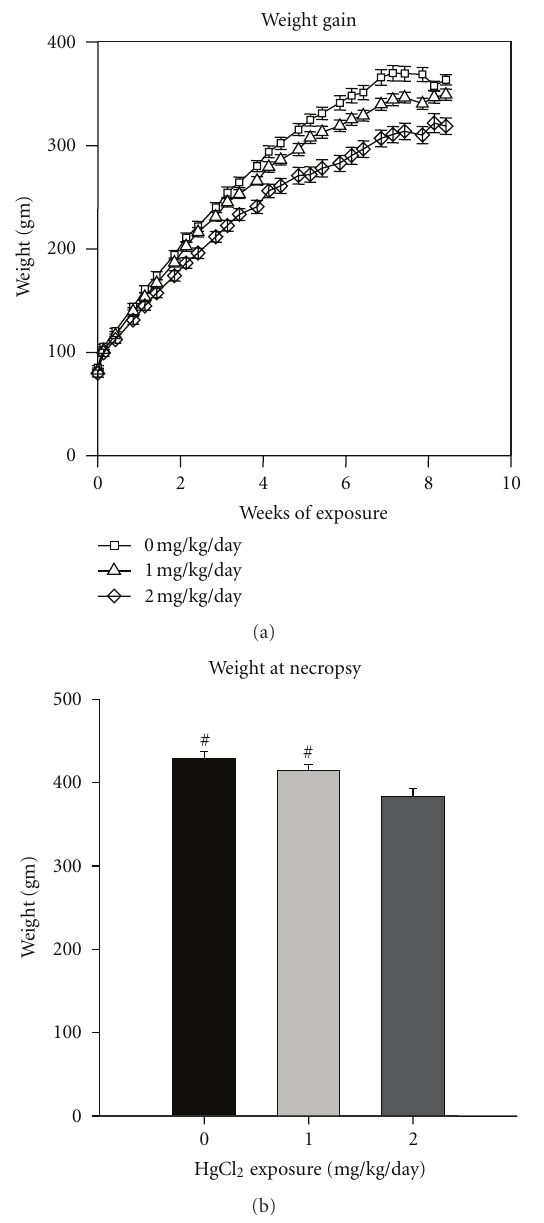
Figure 1: Body weight gain (a) and weight at necropsy (b) of male rats exposed to 0, 1.0, or 2.0 mg/kg/day of HgCl 2 by gavage for 60 days and housed with unexposed female rats for 21 days. Data are mean and standard error. (b) Weight at necropsy. # A significant di ff erence from the HgCl 2 group 2.0mg/kg ( P < 0 . 05).